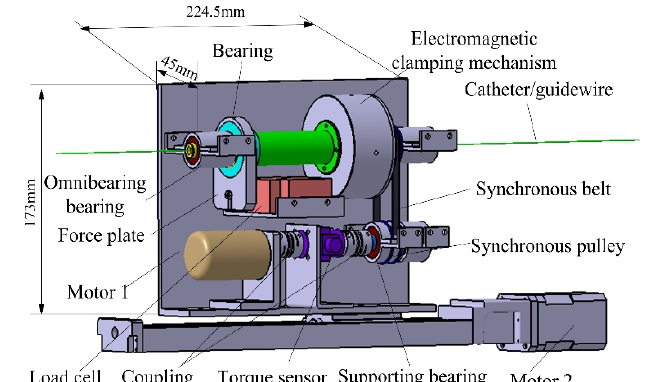
Figure 5. Structure diagram of the slave manipulator.